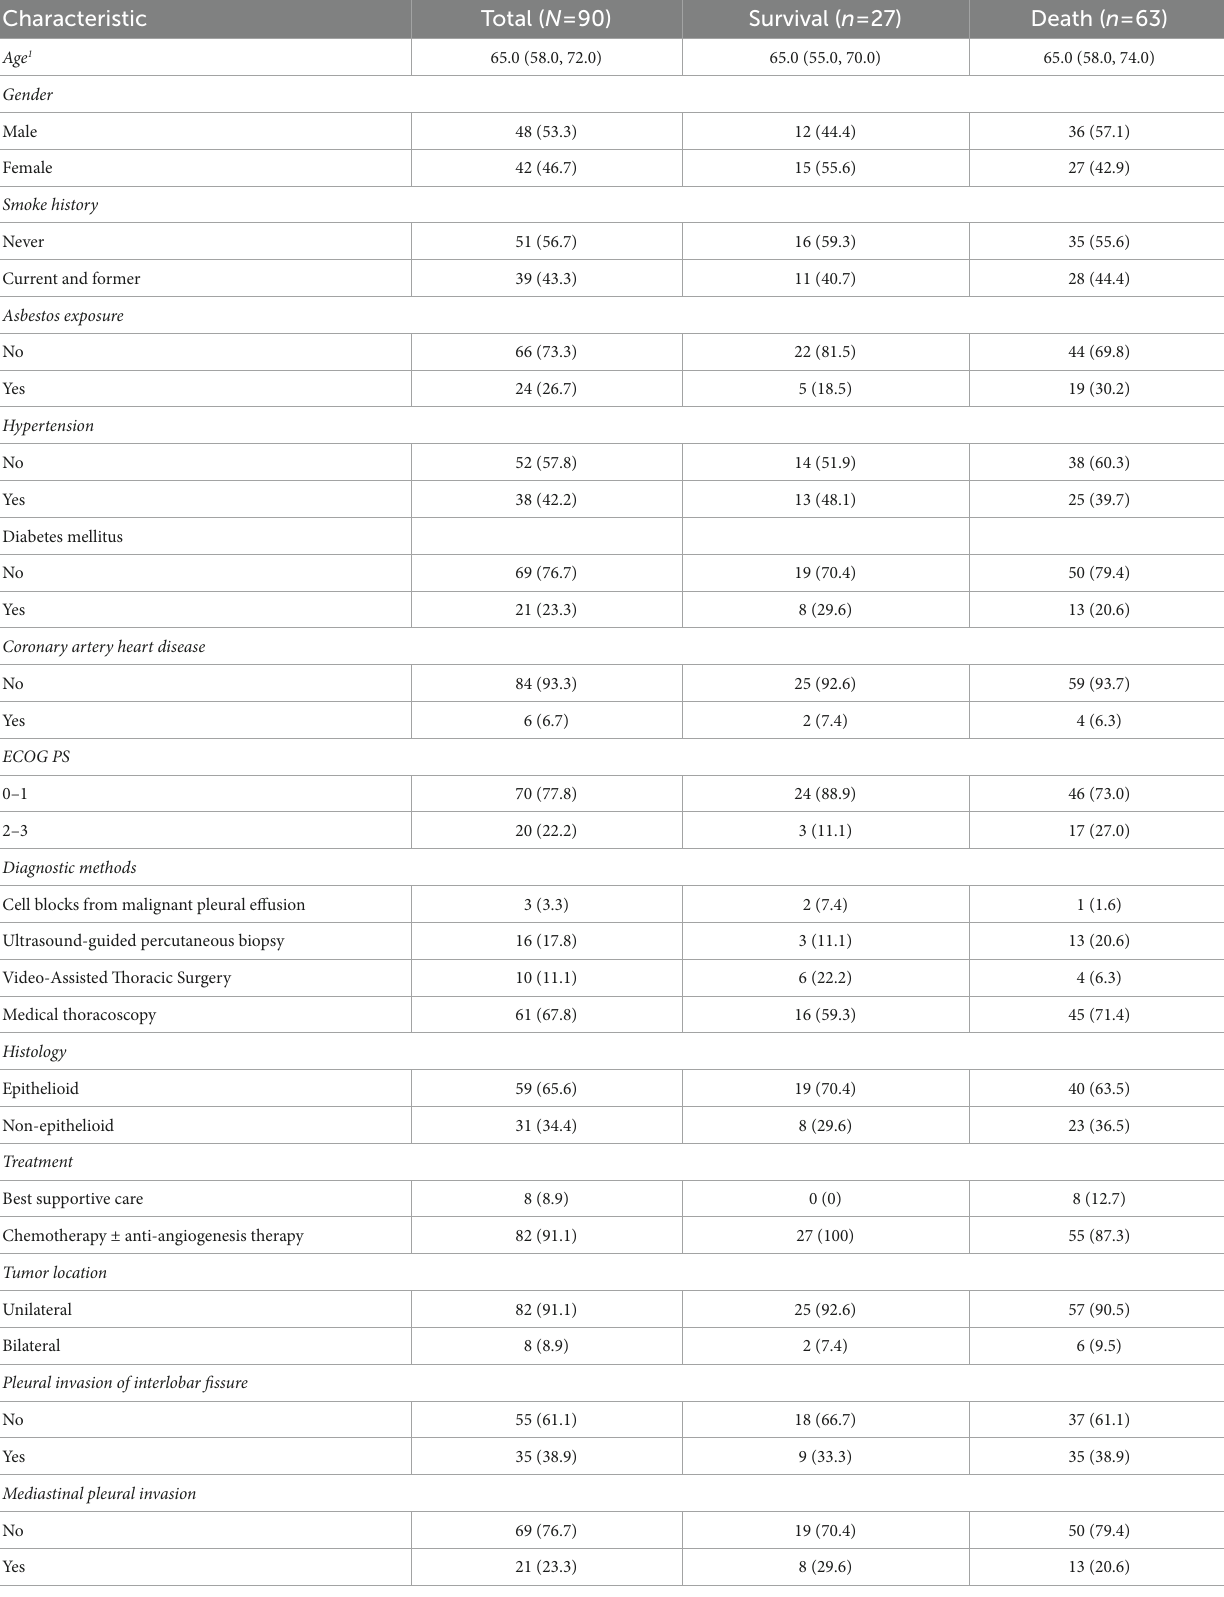
TABLE 1 Baseline characteristics and laboratory variables of the study population.